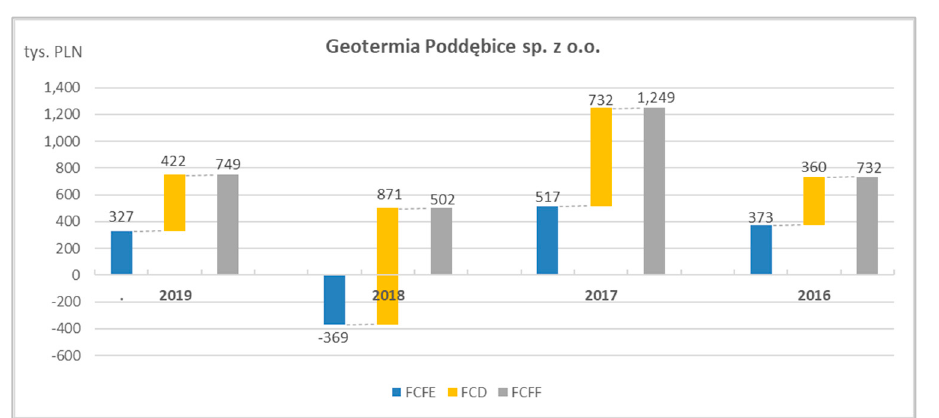
Figure 6. Formation of FCFE, FCD and FCFF in Geotermia Podd ę bice Sp. z o.o. Source: Own study on the basis of: [52].